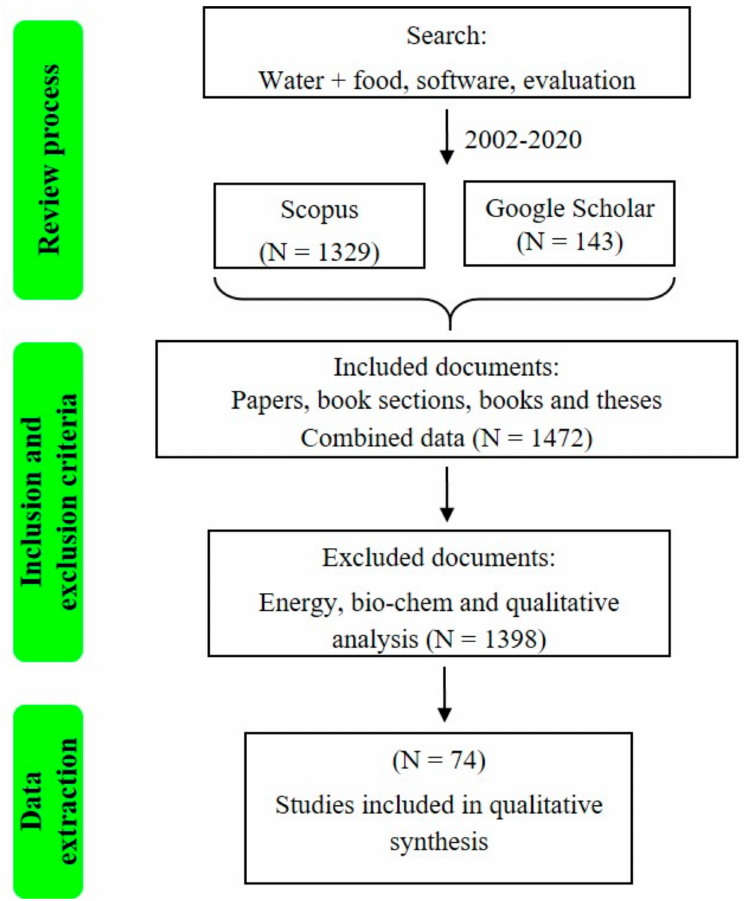
Figure 3. PRISMA according to [35] methodology criteria of the literature